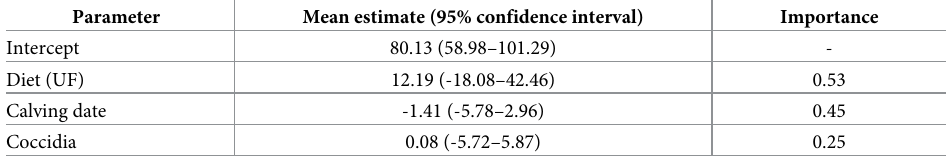
Table 2. Mean Linear Mixed Model (LMM) estimates of multi-model inference parameters of fecal microbiota